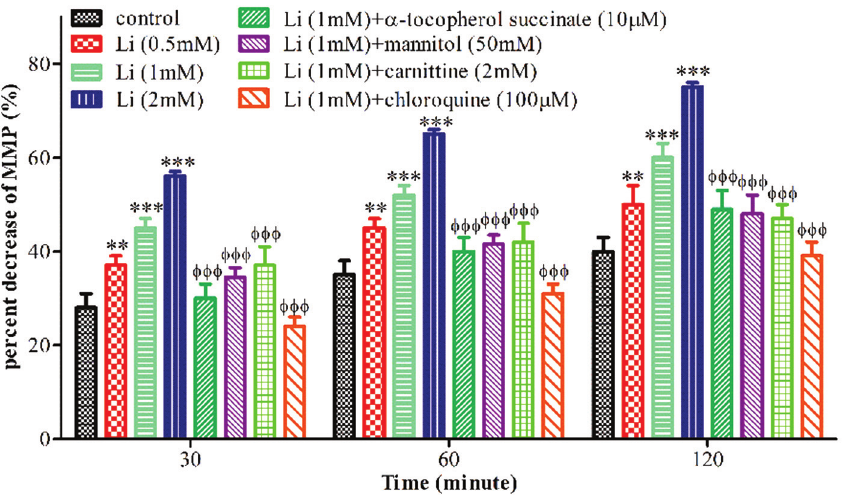
Figure 4: Effect of different concentrations of Li on MMP colapse using primary neuronal cortical culture. The difference in mitochondrial uptake of the rhodamine 123 between the untreated control and Li treated cells is the biochemical basis for the measurement of the percentage of MMP decline. Values are shown as mean ± SD of three separate experiments (n = 3). ** p < 0. 01, *** p < 0.001, significant difference in comparison with non-treated neurons (control). ɸɸɸ p < 0.001, significant difference in comparison with Li (1 mM)-treated neurons.